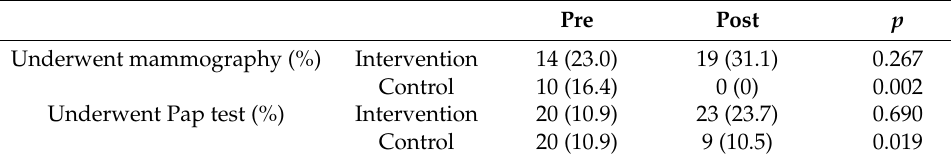
Table 3. Comparison of undergoing mammography and Pap